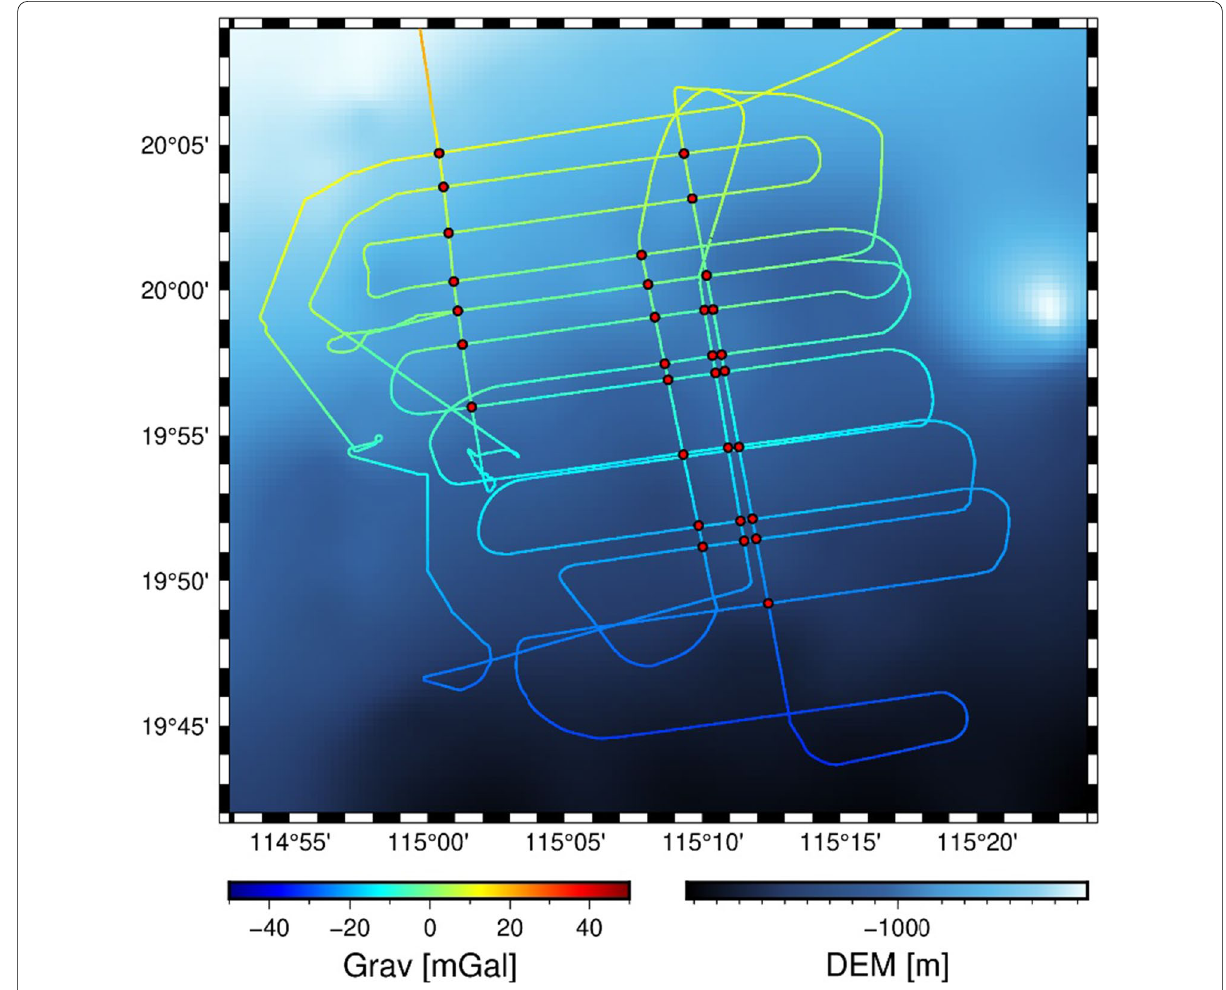
Fig. 4 Grid lines and crossover